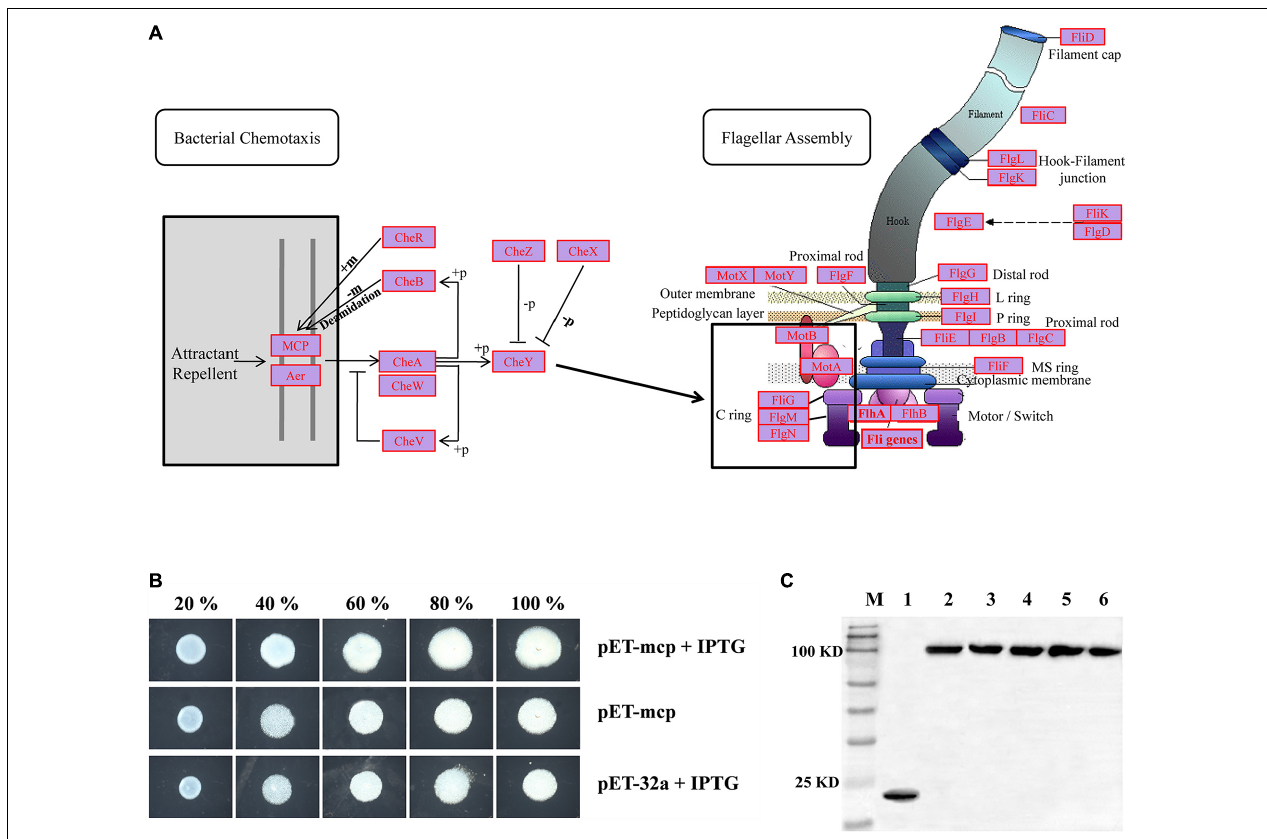
FIGURE 5 | (A) Most presented genes involved in “Bacterial Chemotaxis” and “Flagellar Assembly” KEGG pathways. Most presented genes are indicated by red legend within complete pathways of “Bacterial Chemotaxis” (ko02030) and “Flagellar Assembly” (ko02040). Expression profiles of genes involved in “Bacterial Chemotaxis” and “Flagellar Assembly” KEGG pathways were shown on Supplementary Table 3 . (B) Swarming motility of control-type and MCP expressed strains were examined on swarming permissive agar by spotting normalized cultures of indicated strains and photographed at 20 h. 20, 40, 60, 80, and 100% indicated five different nutrient concentrations used in assays. (C) Western blotting detects expression of MCP proteins. M: Marker; 1: Control strain; 2–6: MCP expressed strains in 20, 40, 60, 80, and 100% nutrient concentrations,